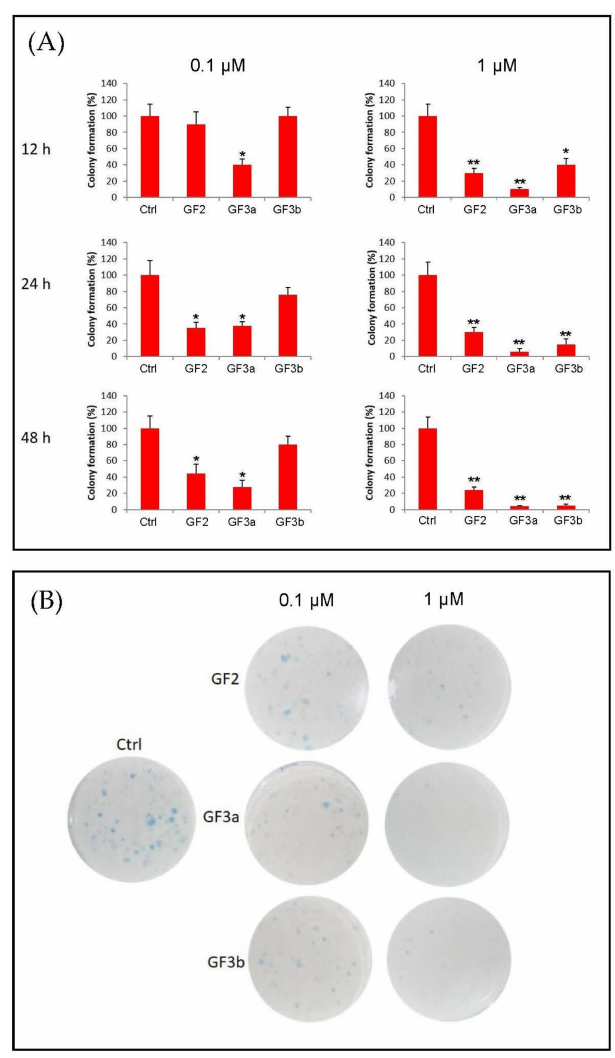
Figure 3. Evaluation of potential toxicity of GF2, GF3a, GF3b fibrous zeolites on HT22 cell line. ( A ) The graphs depict the percentage of colony formation after 12, 24, and 48 h of treatment with the three fibrous zeolites GF2, GF3a, and GF3b at the concentration of 0.1 µ M and 1 µ M. Each value is expressed as a percentage ± SD (N = 3 independent experiments performed in triplicate; * p < 0.05, ** p < 0.01 vs. Ctrl). ( B ) Representative colony images of HT22 cells treated with GF2, GF3a, and GF3b fibrous zeolites after 24 h of